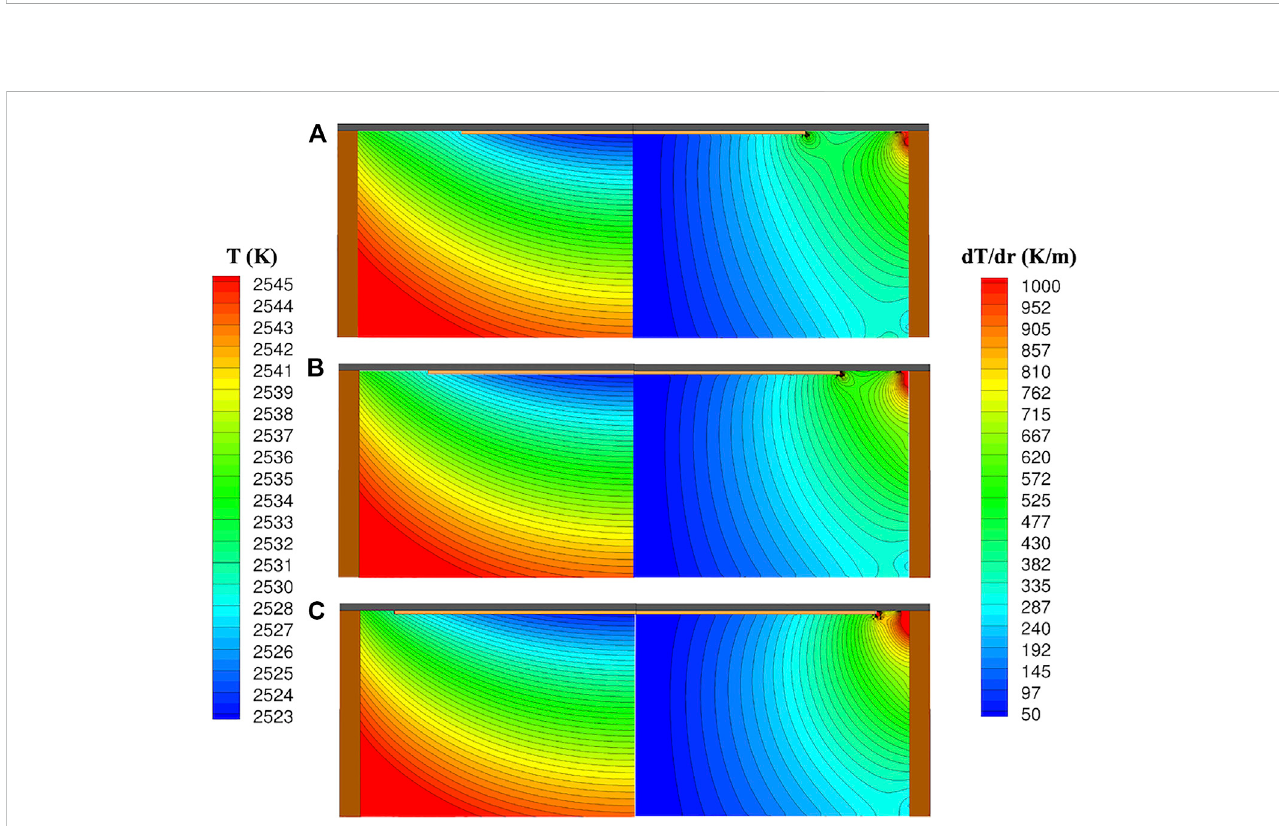
FIGURE 4 Temperature distribution (left) and thermal gradient (right) in the growth chamber mounted with AlN seeds of different sizes: (A) Φ 51, (B) Φ 62, and (C) Φ 70 mm, calculated by FEMAG and in-house FEM codes.